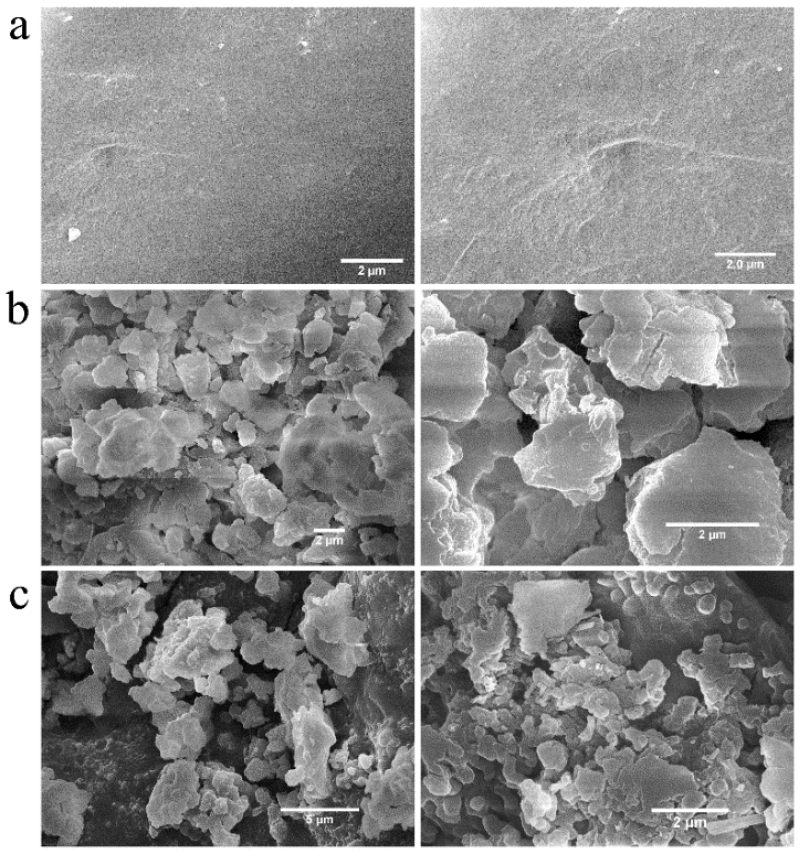
Figure 6. SEM images of NVF-St copolymer sample (No.6) prepared under different drying conditions. ( a ) Vacuum-dried; ( b ) freeze-dried; and ( c ) hydrolyzed, dialyzed, and freeze-dried. Table 2. Comparison of BPA adsorption capacity of the copolymer with commonly used activated carbon and polymer adsorbents reported in the literature.